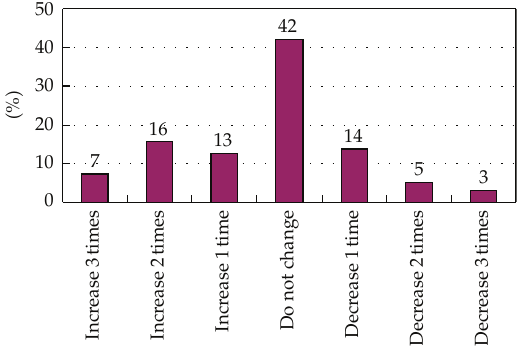
Figure 10: Park and ride travel intent.